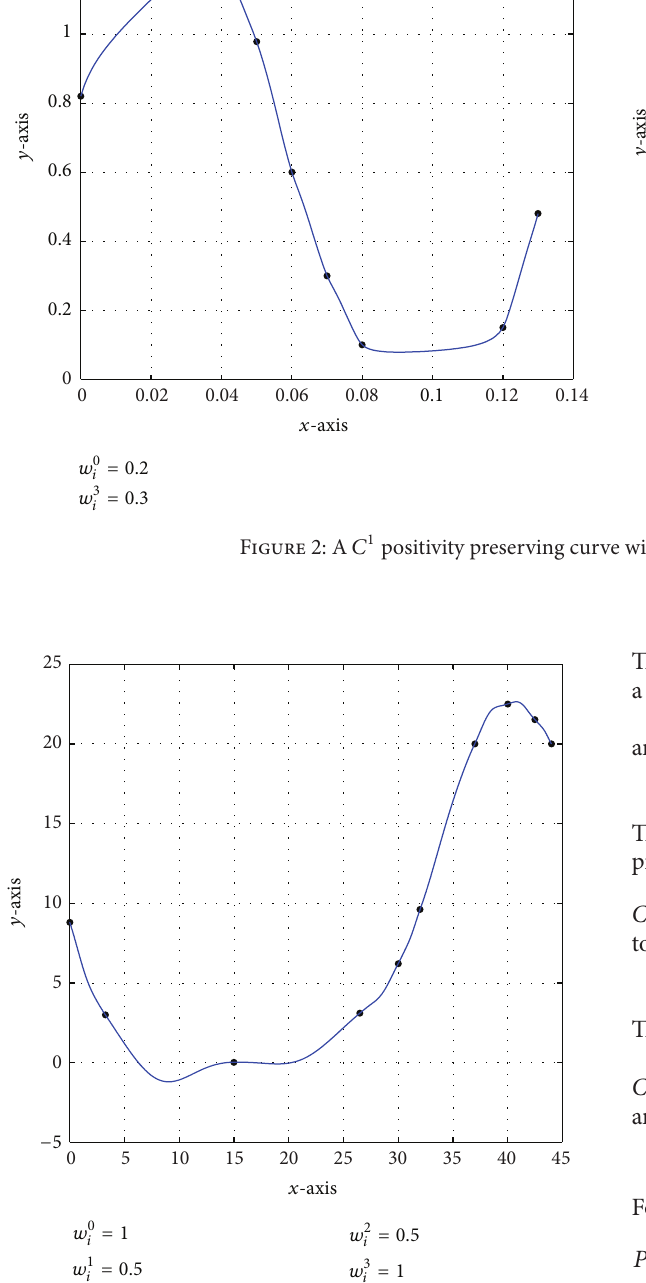
Figure 3: Nonpositive rational cubic trigonometric